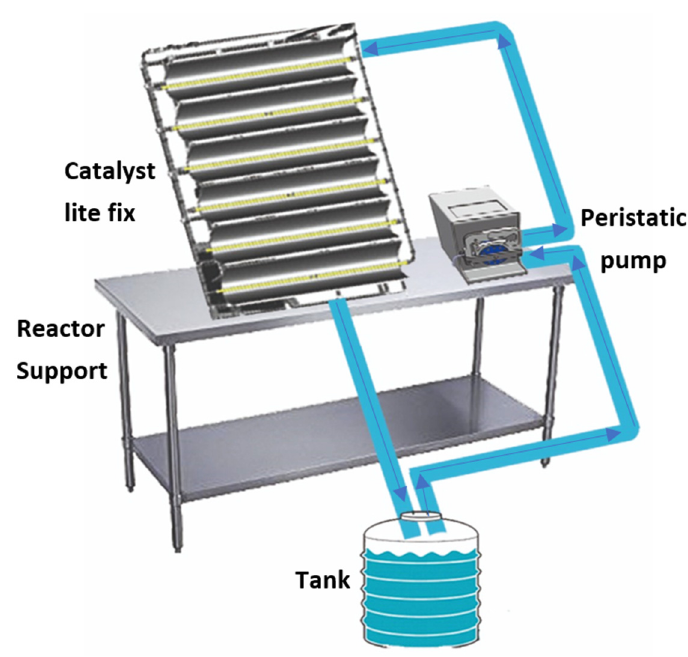
Figure 2. Operating diagram of the staircase reactor.